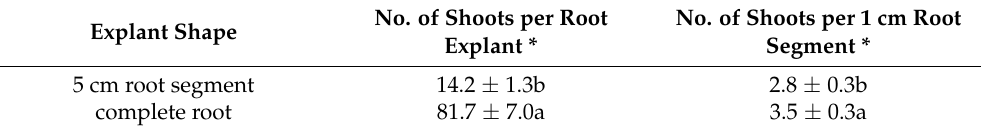
Table 2. Effects of root explant shapes on shoot induction.